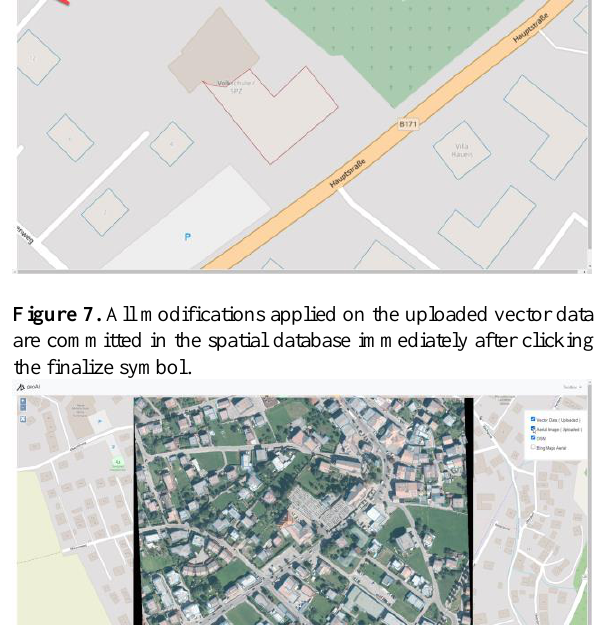
Figure 4. Layer switcher to control the layer visibility by the user.